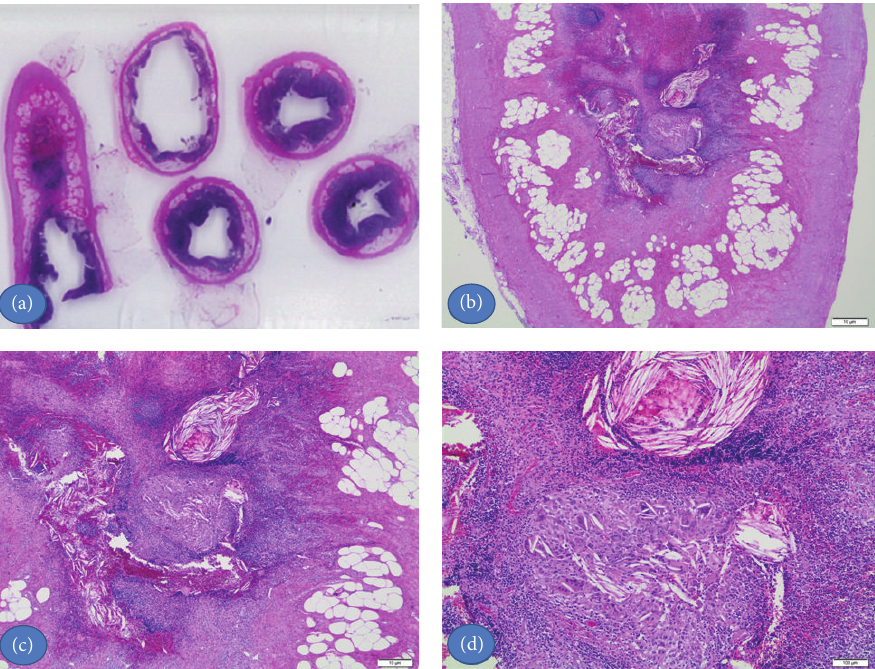
Figure 1: H&E stained section of the appendix. (a) and (b) Lower magnification shows the xanthogranulomatous focus in the tip of the appendix. (c) and (d) At higher magnification the typical appearance of xanthogranulomatous inflammation with it is component, the xanthoma cells, giant cells, cholesterol clefts, chronic inflammatory cells and hemorrhage.